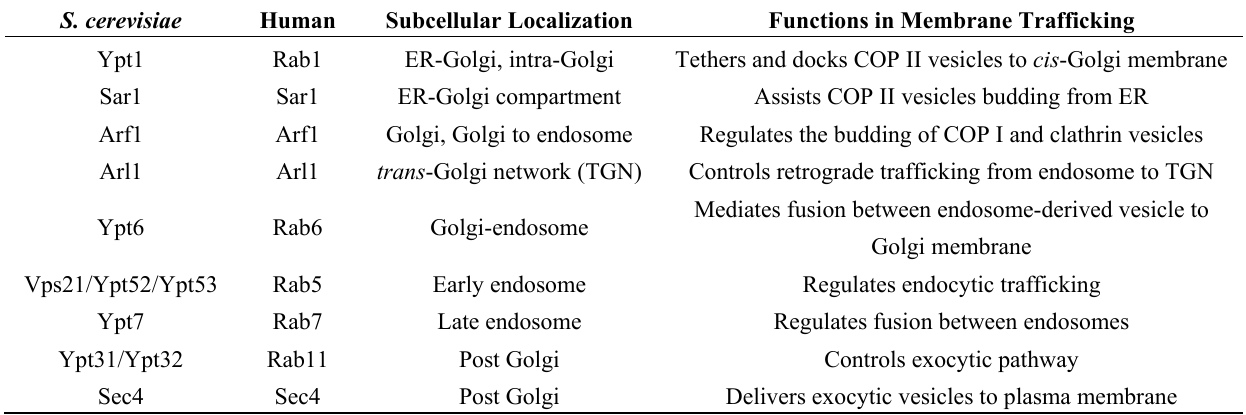
Table 1. Membrane trafficking related monomeric GTP-binding proteins in yeast and their homologs in